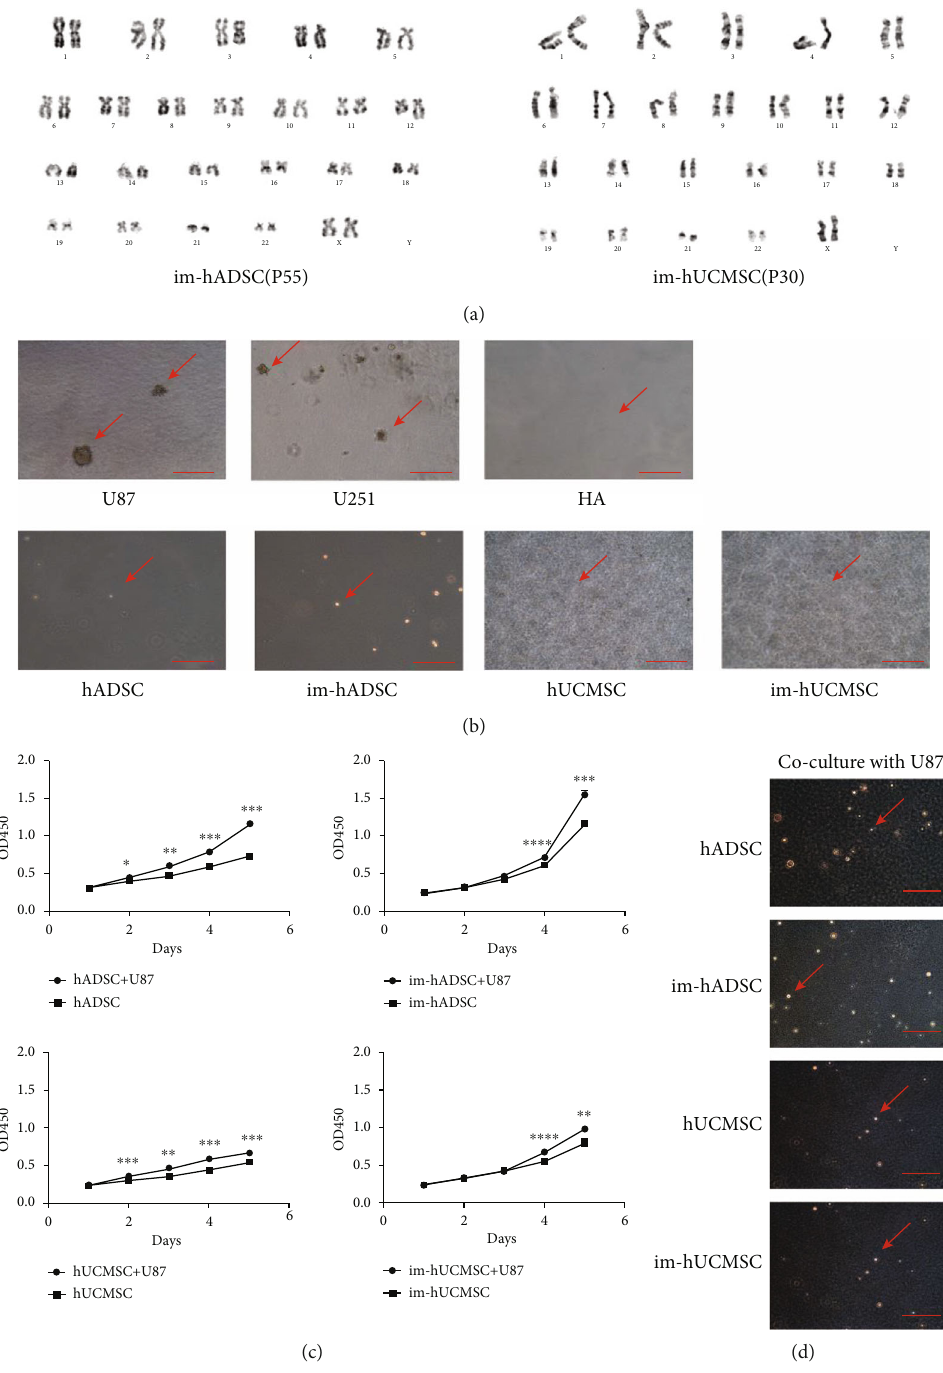
Figure 4: Safety of immortalized mesenchymal stem cells in vitro. (a) Karyotype analysis of immortalized mesenchymal stem cells. (c) Soft agar clone formation test to detect the clone formation ability of immortalized mesenchymal stem cells, GBM cell lines (U87 and U251) were used as a positive reference, and normal glial cells (HA1800) were used as a negative reference. (c) Cell proliferation curve of mesenchymal stem cells that indirectly co-cultured with U87 cells, detected by the CCK-8 assay. (d) Soft agar clone formation experiment was used to detect the clone formation ability of immortalized mesenchymal stem cells co-cultured with U87 cells indirectly. Magni fi cation, × 100. Scale bar, 500 μ m. ∗ P < 0 : 05 , ∗∗ P < 0 : 01 , ∗∗∗ P < 0 : 001 , ∗∗∗ ∗ P < 0 : 0001